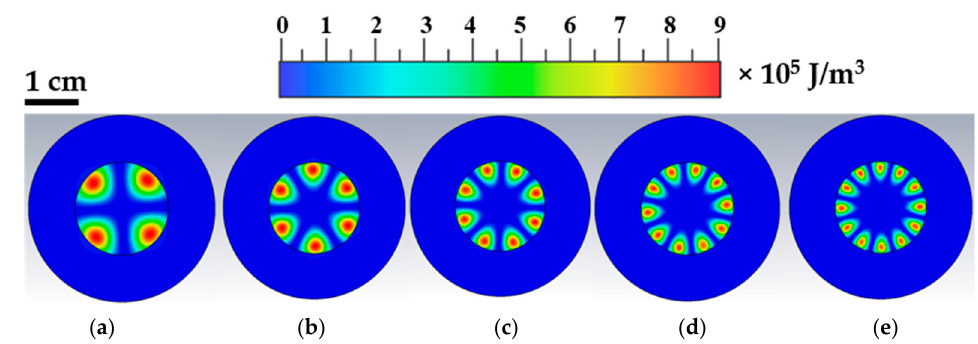
Figure 4. Computer electromagnetic simulations: electric energy densities at resonance. In the frequency range from 6 to 14 GHz, five WGM resonances have been found: ( a ) WGM n=2 ; ( b ) WGM n=3 ; ( c ) WGM n=4 ; ( d ) WGM n=5 and ( e ) WGM n=6 . The five panels report the expected electromagnetic field distribution at the WGM resonances.